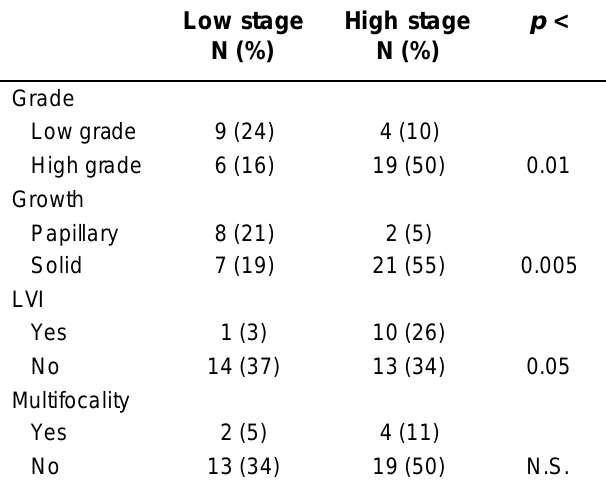
Morphological Finding and Pathological Stage in BEN